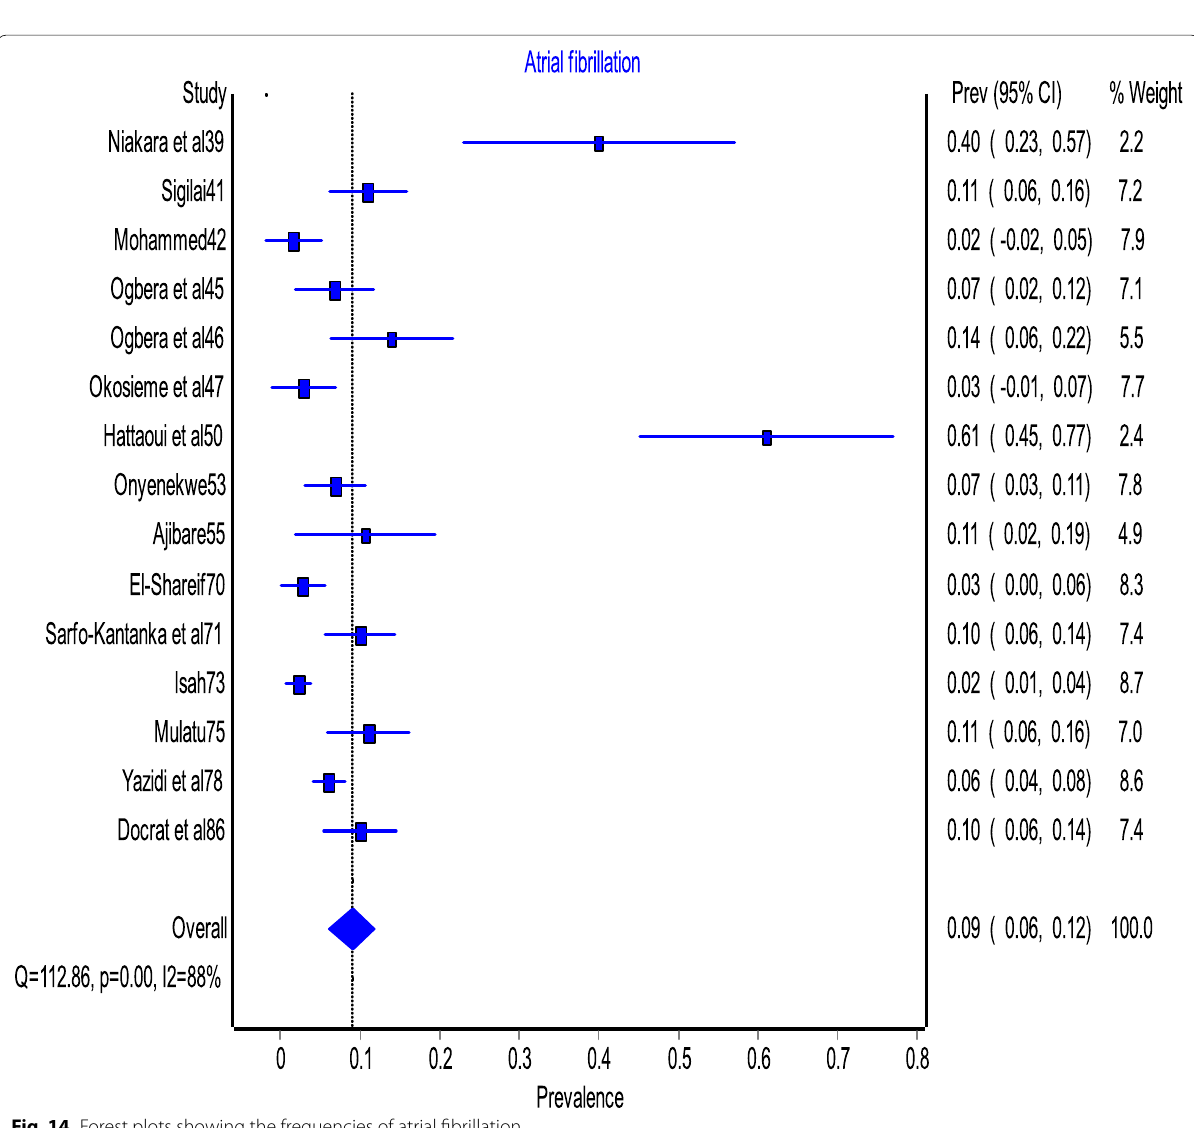
Fig. 14 Forest plots showing the frequencies of atrial